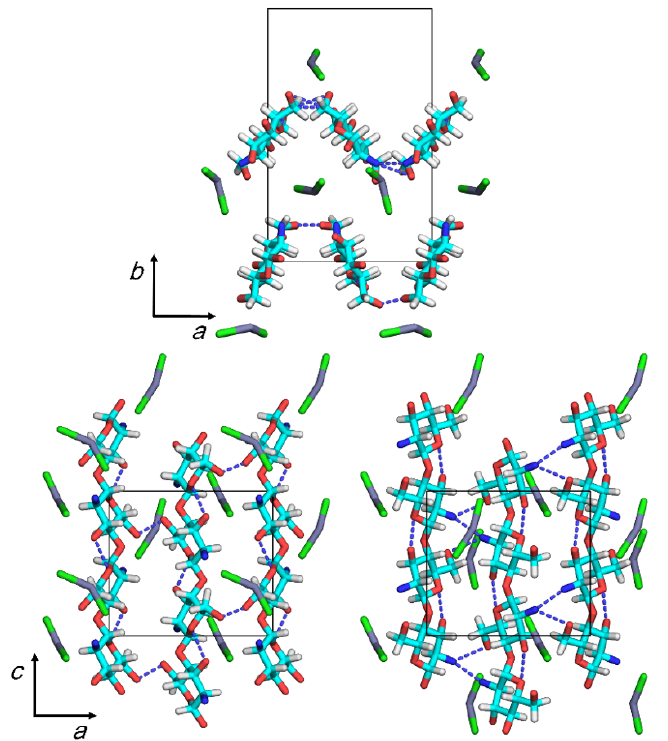
Figure 4. Projections of the proposed crystal structure on the ab (top) and ac (bottom) base planes (left: the chain sheet consisting of chains 1 and 2; right: the chain sheet consisting of chains 3 and 4). Dashed lines indicate hydrogen bonds.